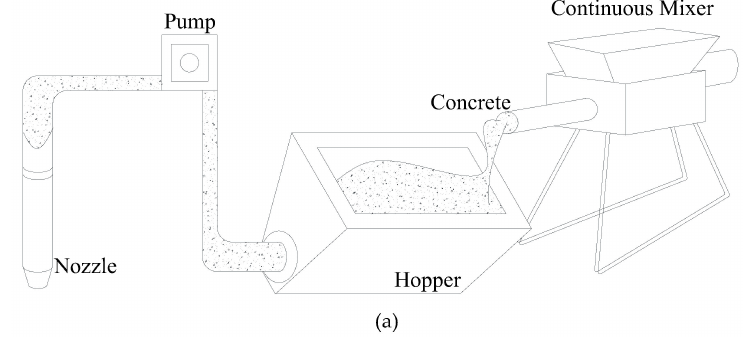
Figure 1. Classification of printing start point at each layer. ( a ) Optimized printing start points for fastest printing speed; ( b ) Selected printing start points closest to specific